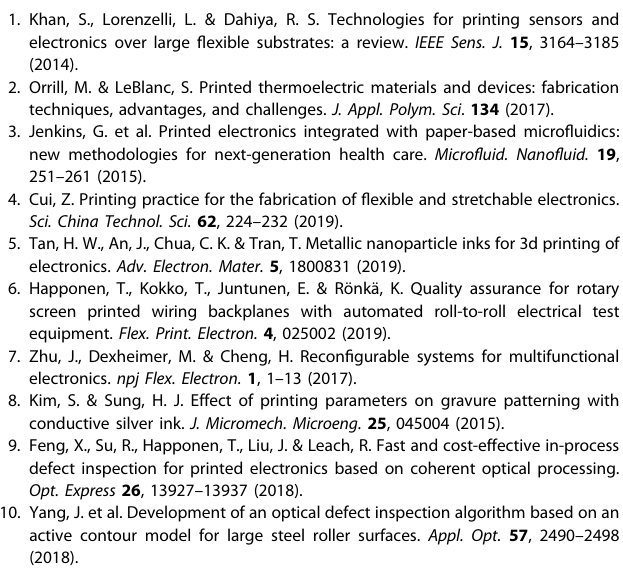
The Finite-difference time-domain method using a linear polarized light and a periodic boundary condition was used for simulation of the expected transmission of i -MCBs and c- MCBs with varied voids (see Supplementary Fig. 4 for more details) 13 .